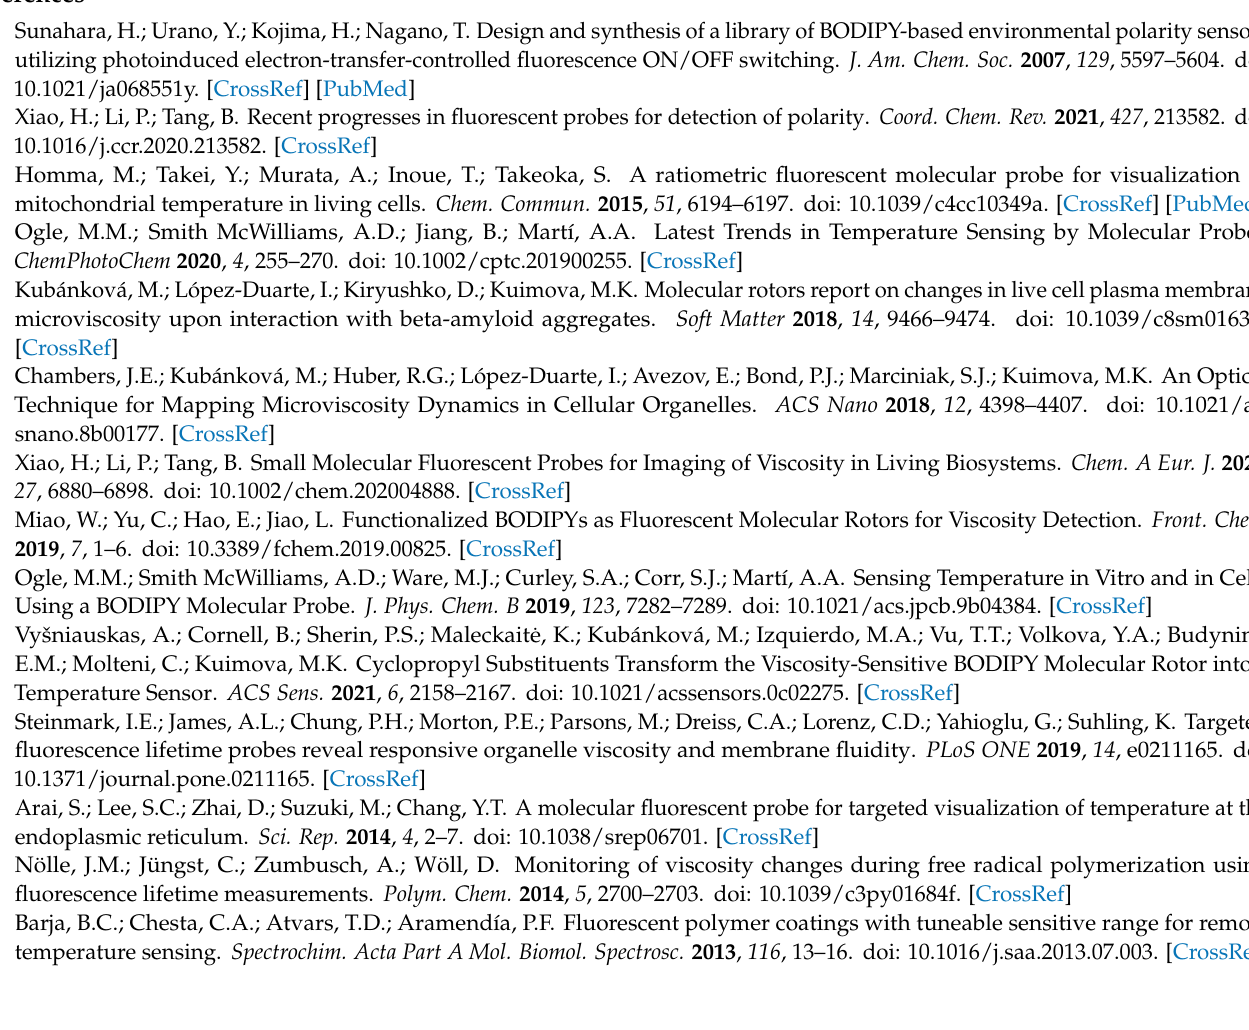
radiative relaxation, Figure S8: Visual scale for BODIPY-based rotors when the ratio τ max ⁄ τ min is equal to 100 (A) and 2500 (B), Figures S9–S24: NMR spectra of derivatives studied in this